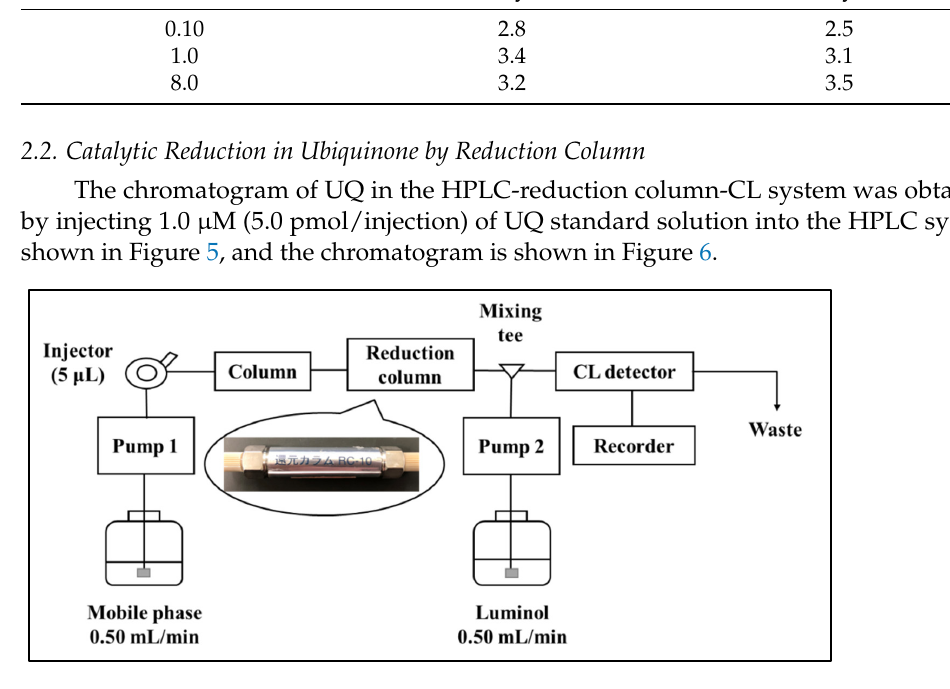
Figure 5. HPLC-CL system employing the reduction column. Figure 2. HPLC − CL system employing the electrolytic reduction.